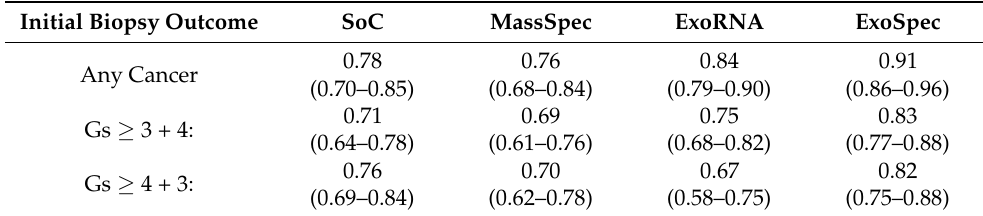
Table 3. Area under the receiver operator curve (AUC) values of all four trained models for detecting disease on an initial biopsy: (i) Any cancer, (ii) Gleason score (Gs) ≥ 3 + 4, (iii) Gs ≥ 4 + 3. SoC uses only clinically available information, MassSpec uses only peptide mass spectrometry data, ExoRNA uses only EV-RNA information, and ExoSpec is a multi-omics integrated model combining all data. Numbers within brackets are 95% confidence intervals for the AUC, calculated from 1000 stratified bootstrap resamples. Input variables for each model are detailed in Table